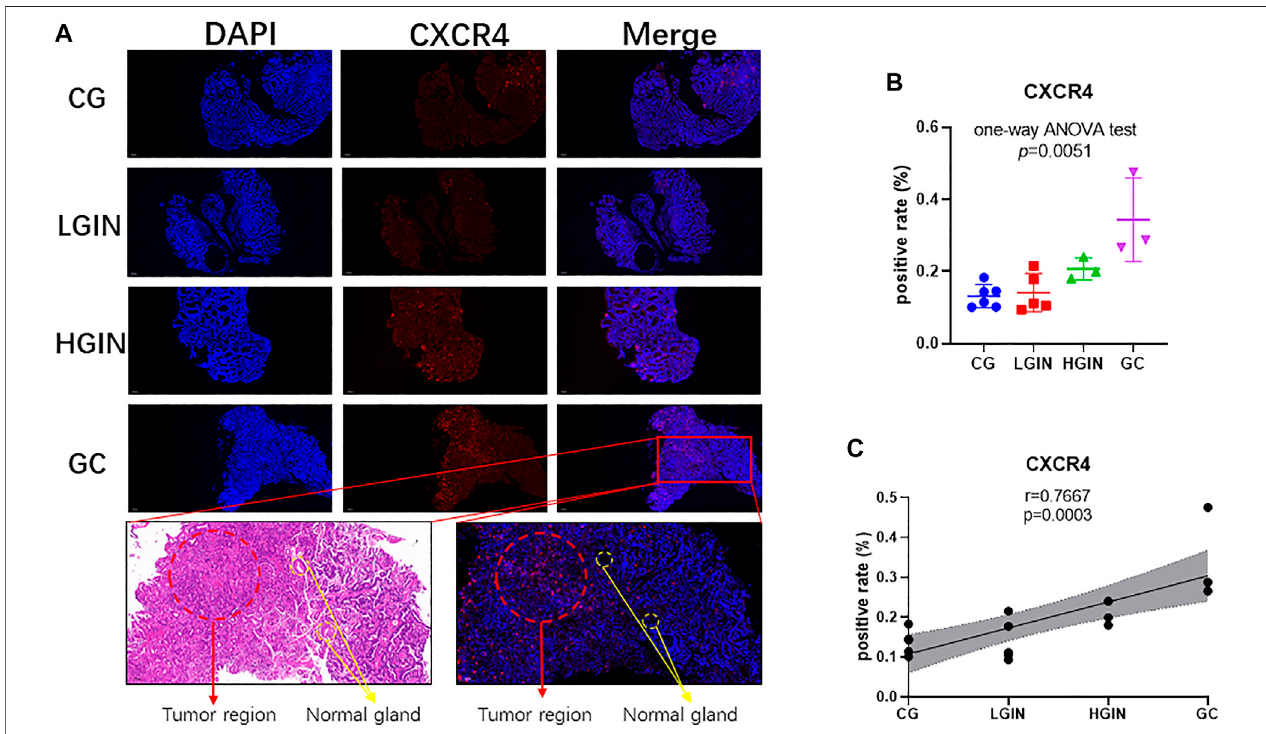
FIGURE 3 | Expression of CXCR4 in different pathological stages of stomach tissues. (A) Immuno fl uorescence (scale bar (cid:2) 200 μ m). (B) Gene expression level of CXCR4 in the pathological stage. (C) Scatter plot showing the correlation between CXCR4 expression levels and the pathological